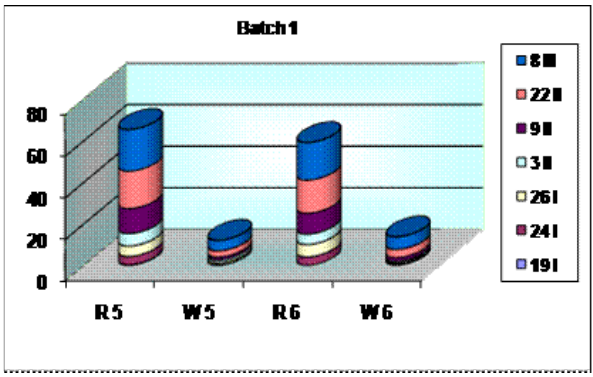
Fig. 5. The final average length of the branches, in cm, for batch 1